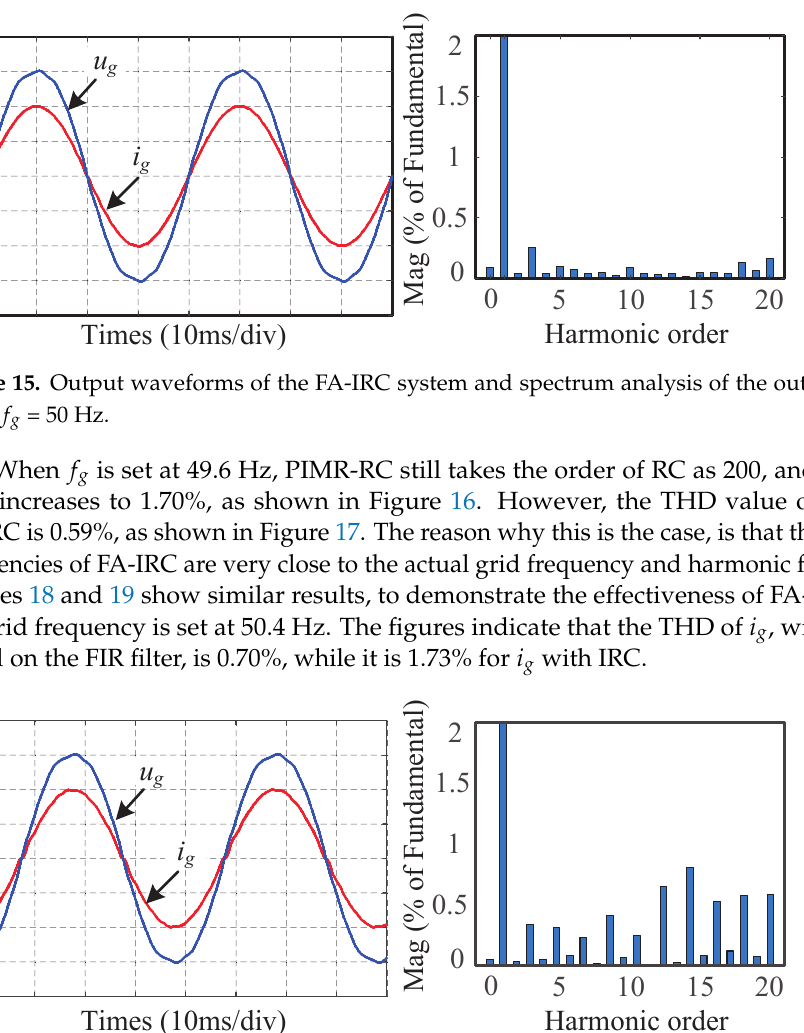
Figure 14. Output waveforms of the PIMR-RC system and spectrum analysis of the output current when f g = 50 Hz.